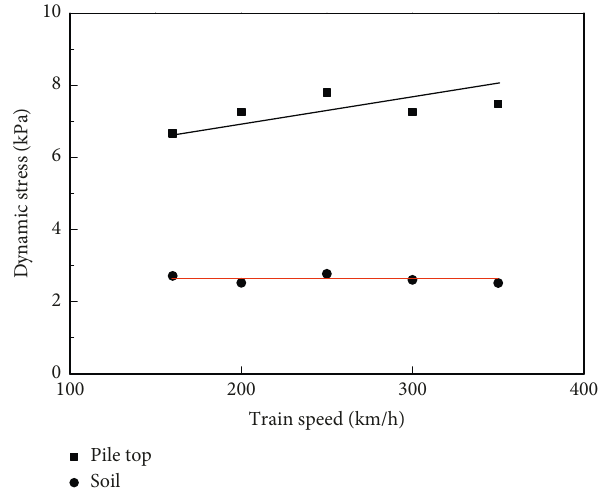
Figure 10: Relationship curves between dynamic stress responses of soil at pipe top and between piles and the train